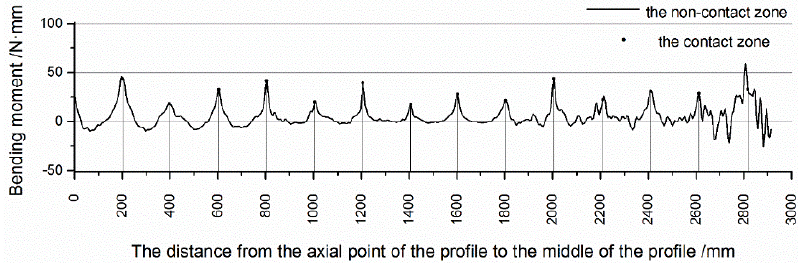
Figure 12. The distribution of bending moment in the forming profiles.